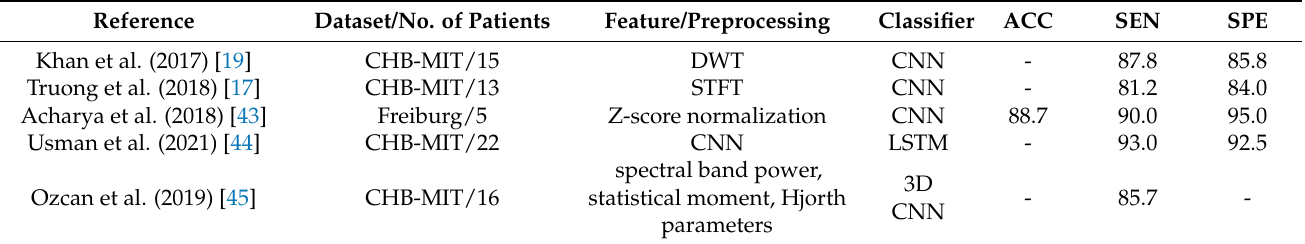
Table 7. Comparison of recent segment-based seizure prediction studies conducted using CHB-MIT dataset with proposed